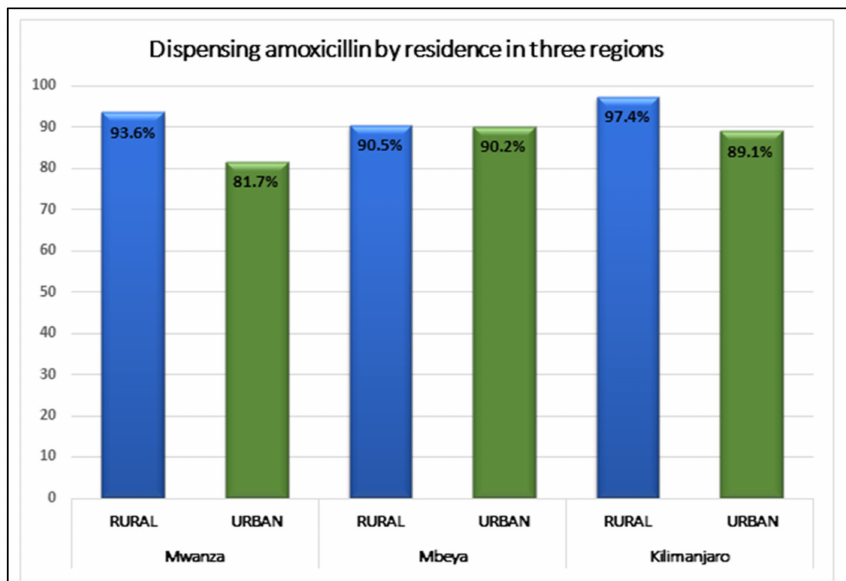
Figure 4. Location of outlets dispensing amoxicillin without prescription in three